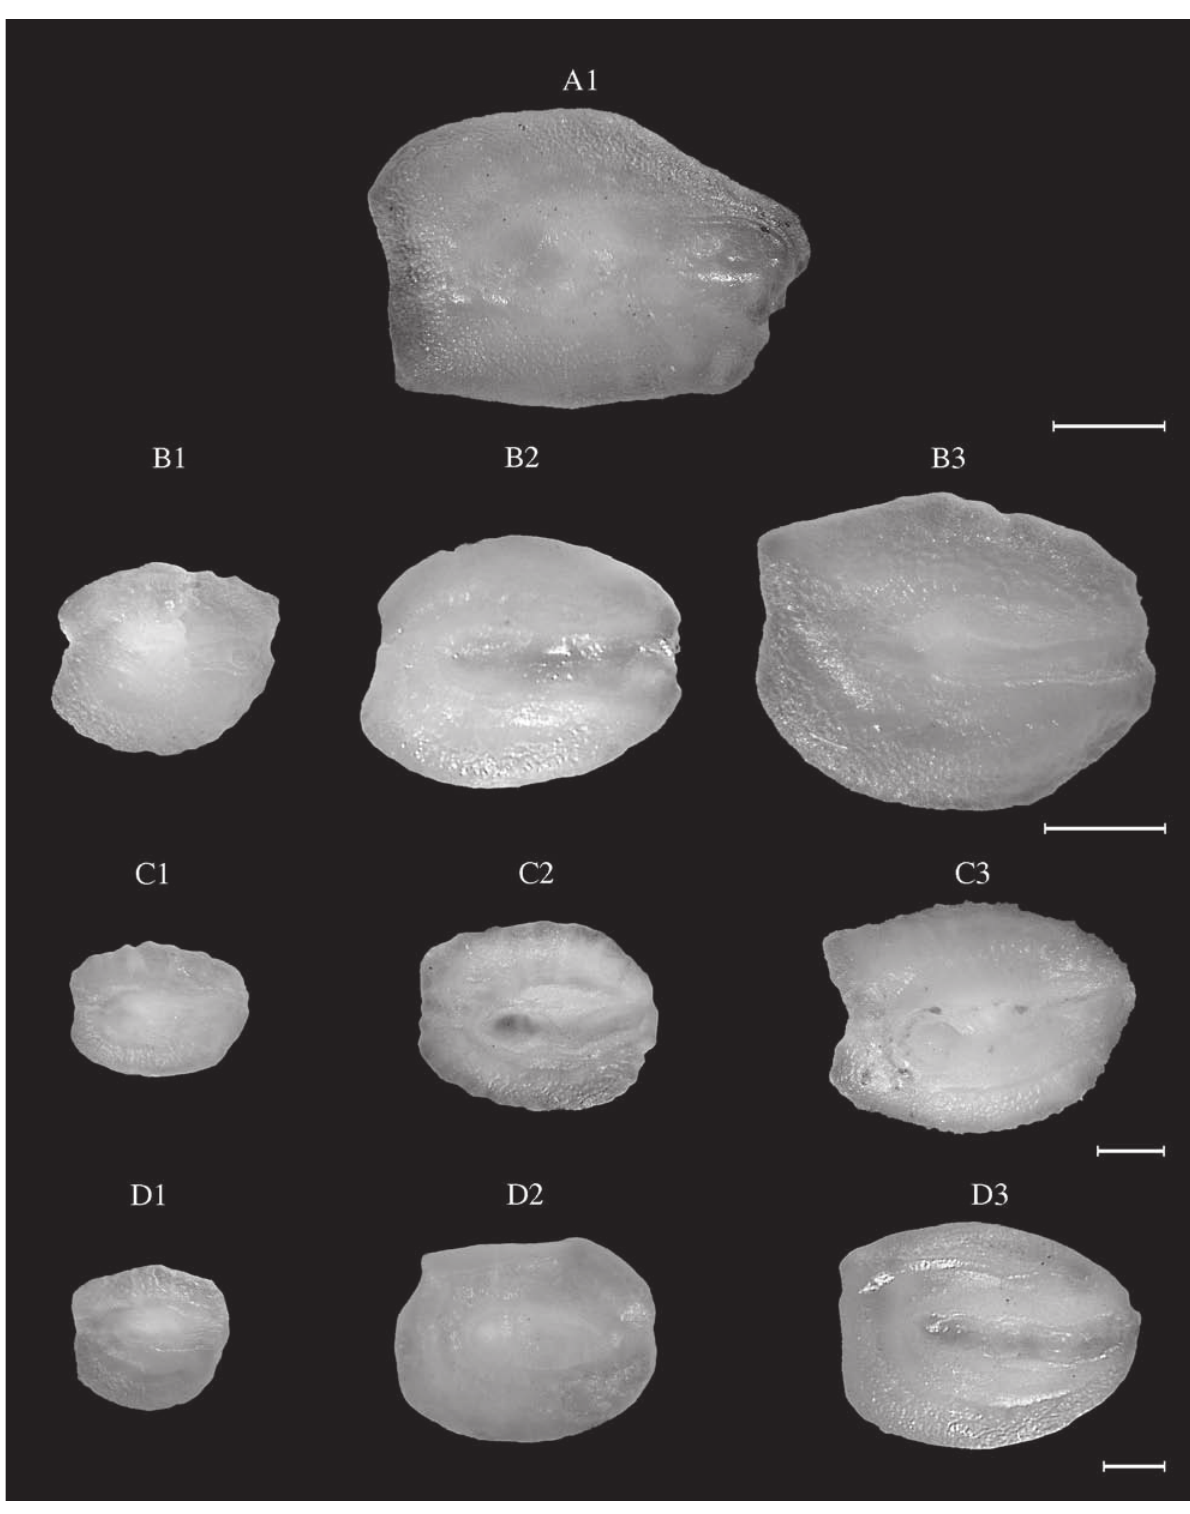
Fig. 93. – Pegusa cadenati (CEA) . TL: A1, 23.8 cm. Pegusa lascaris . TL: B1, 11.6 cm (NEA); B2, 19.0 cm (WM); B3, 25.6 cm (NEA). Solea senegalensis. TL: C1, 16.2 cm (NEA); C2, 26.0 cm (WM); C3, 32.7 cm (CEA). Solea solea. TL: D1, 16.2 cm (NEA); D2, 23.1 cm (CEA); D3, 36.5 cm (WM). Scale bar = 1